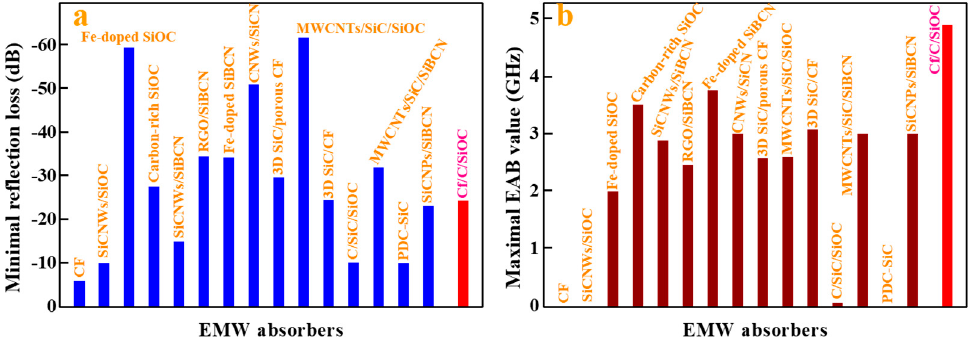
Figure 10. Comparison of ( a ) minimal reflection losses and ( b ) widest effective absorption bandwidth (EAB) values of different electromagnetic wave (EMW) absorbers reported by recent literature.